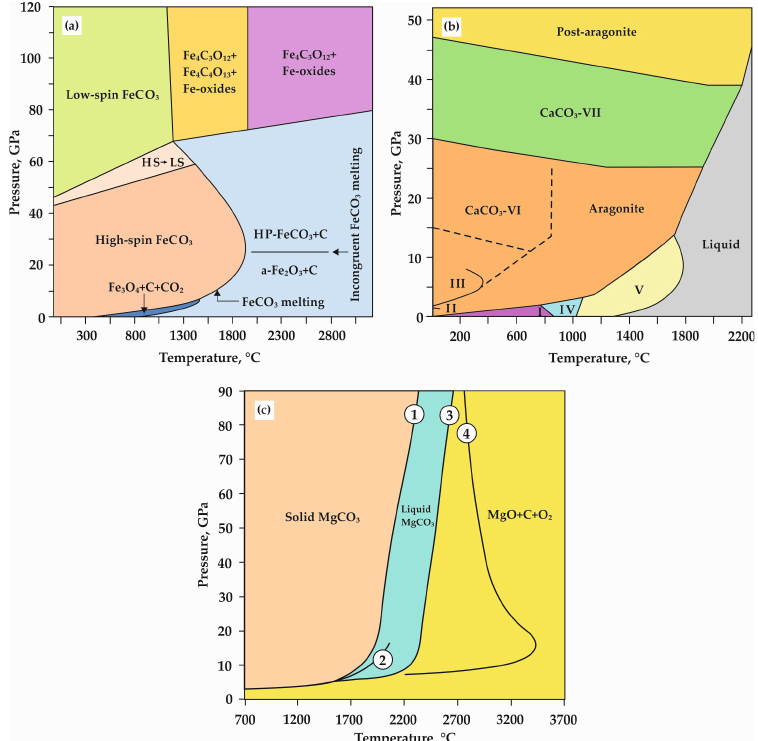
Figure 1. Experimentally determined P,T-diagrams of FeCO 3 ( a ) (modified from [36–40]), CaCO 3 ( b ) (modified from [41,42]) and MgCO 3 ( c ) (1—melting curve of MgCO 3 [43]; 2—melting curve of MgCO 3 [44]; 3—decomposition of liquid MgCO 3 into MgO and CO 2 [43]; 4—calculated decomposition of MgCO 3 [45]. HS—high-spin, LS—low-spin, HP—high-pressure, I,II,III,IV,V—CaCO 3 phases.